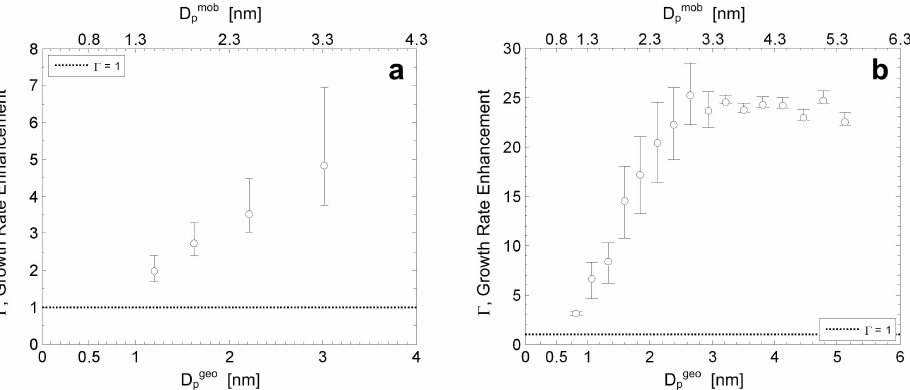
Fig. C2. Effects of systematic uncertainties in particle detection and charging efficiencies on growth rate enhancement 0 as a function of particle mobility diameter D mob p (upper abscissa) and particle geometric diameter D geo p (lower abscissa) for the NPF event observed on (a) 7 August 2009 (09:50, NCCN) and on (b) 19 September 2010 (12:40–13:00, NCAR). Values of 0 calculated using the size-dependent detection efficiency of negatively charged NaCl and the bipolar charging efficiency using the parameterization of Wiedensohler (1988) are presented as open circles. Resulting upper and lower limits on 0 , based on assumed systematic uncertainties in the product f detection · f charging , are shown for each value of 0 as horizontal bars. A line indicating 0 = 1 is shown for reference. Geometric particle diameters were estimated according to Larriba et al.